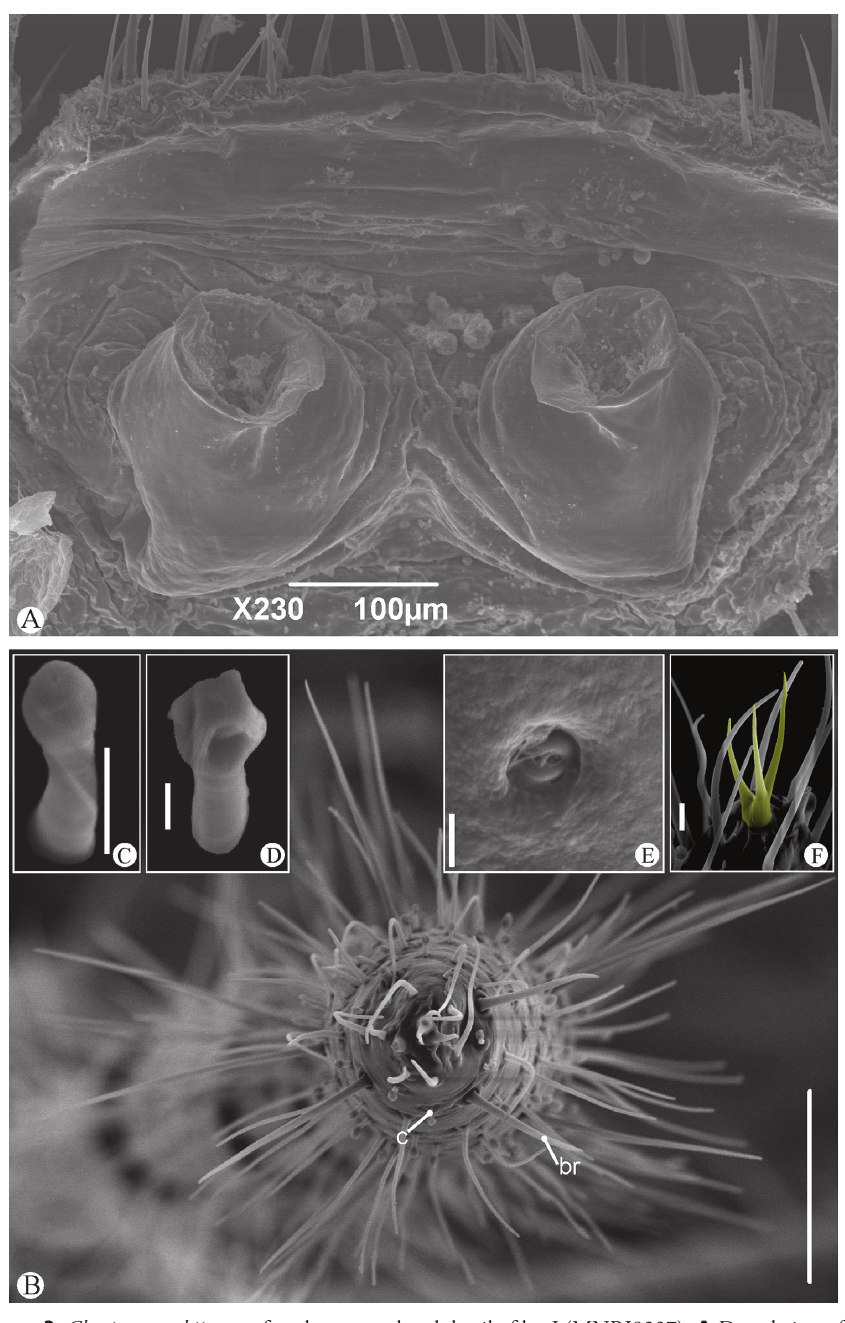
Figure 3. Charinus ruschii sp. n. female gonopod and detail of leg I (MNRJ9237). A Dorsal view of the female gonopod B Frontal view of the tip of leg I C Detail of sensitive hair type 1 D Detail of sensitive hair type 2 E Glandular opening close to the tip of the tarsus F Modified claw in the tip of the leg. Ab- breviations: br: bristle sensilla; c: club sensilla. Scale bars: B : 100 um; C : 5 um; D, E : 2 um; F : 10